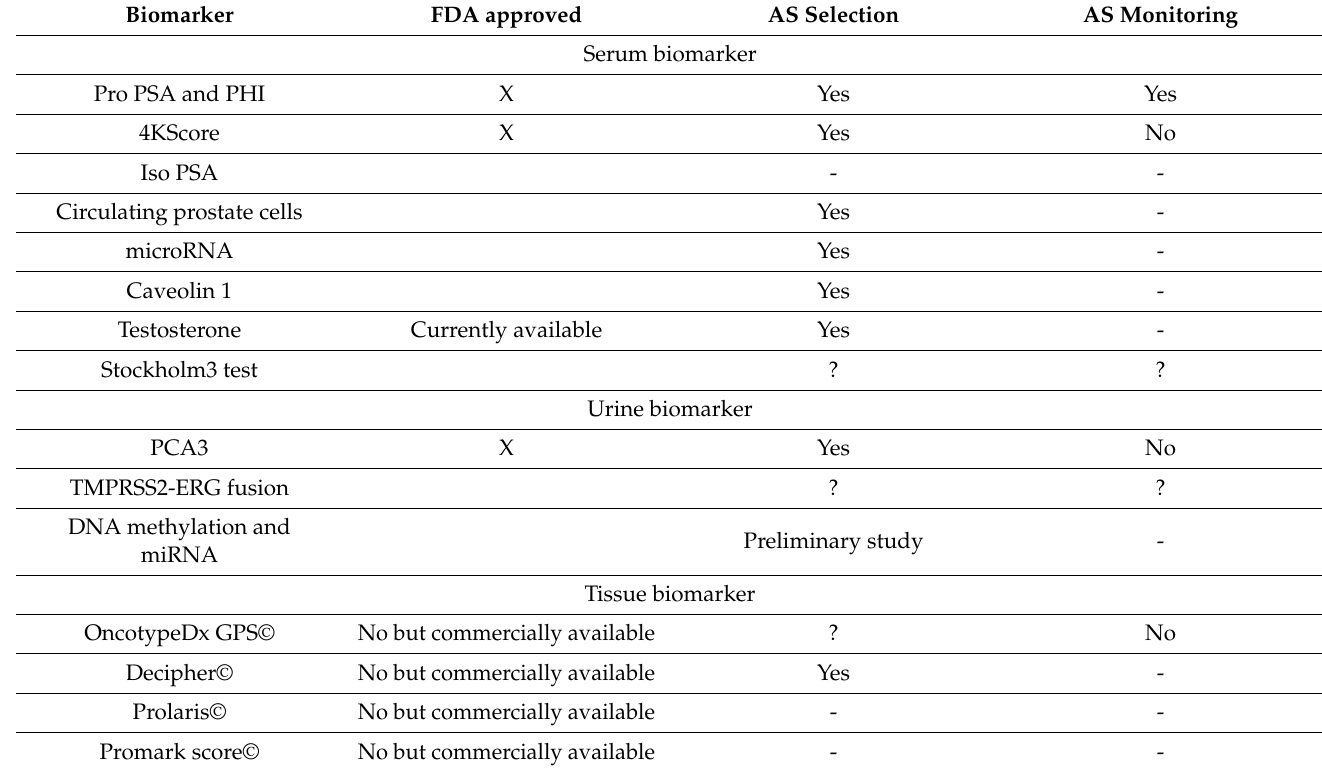
Table 4. Biomarkers’